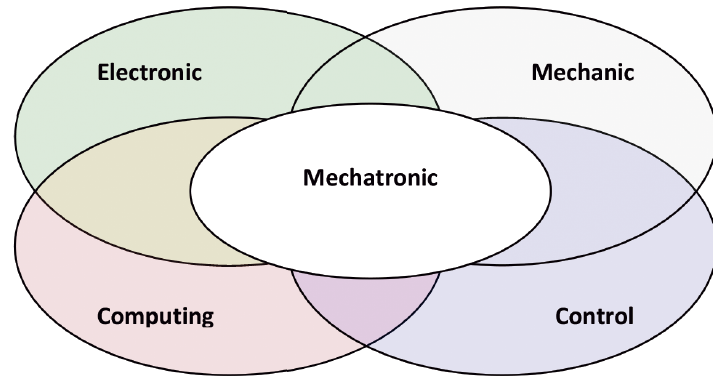
Figure 1. Mechatronic